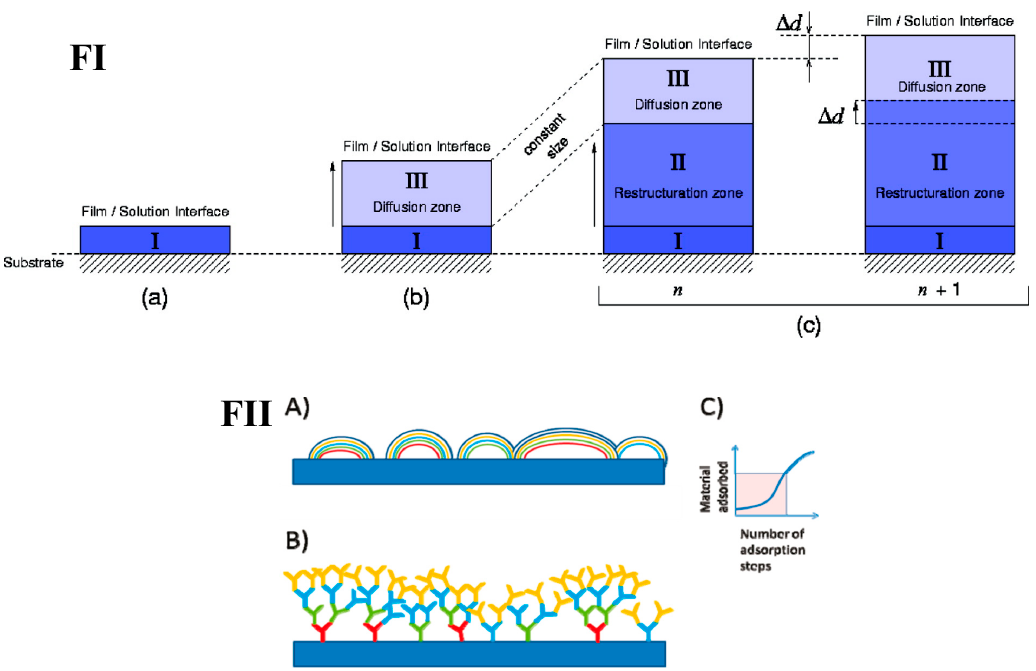
Figure 7. Models of film build up. (FI ) Model of the restructuration zone; ( a ) initial film build-up upon the substrate, ( b ) the development of the diffusion zone within the film, and ( c ) the formation of the re-structuration zone, including the case where the number of deposition steps increases from n to n + 1 ( FII ) The substrate for film fabrication is shown as a horizontal slab. The film resulting from successive polymer adsorption steps is shown via different colours, each representing a polymer layer. ( A ) Island model, ( B ) Dendritic model, and ( C ) Approximate growth of material deposited. ( FI ) is